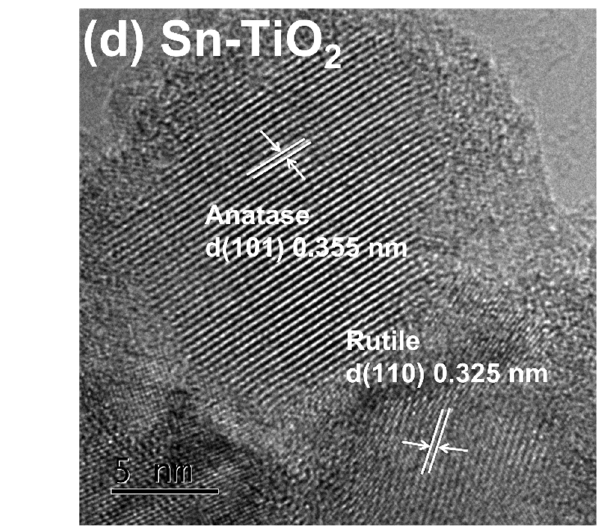
Figure 3. TEM and HRTEM images of pure TiO 2 ( a , c ) and Sn–TiO 2 ( b , d ).